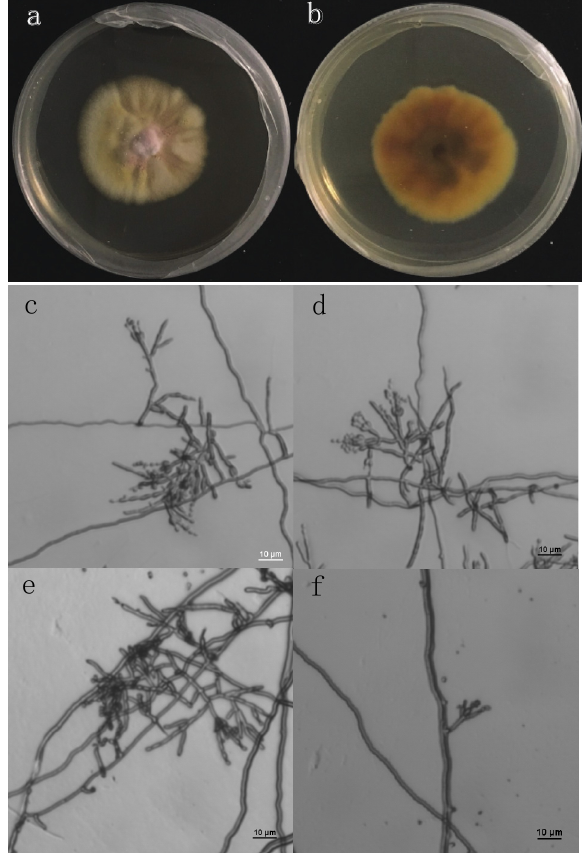
Figure 1. Fungal colonies and spores. ( a , b ): front and back view of fungal colony on a culture plate. ( c – f ): morphology of fungal spores. Table 1. Inhibition activities of fractions on P. falciparum asexual stage